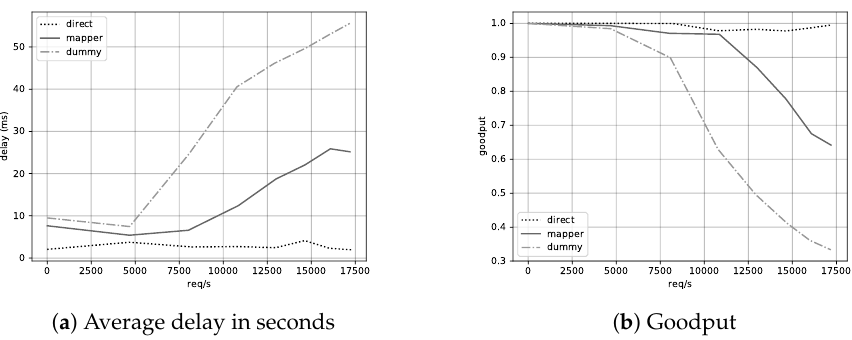
Figure 11. The latency (in seconds) and goodput for six MQTT adapters measured for different configurations in